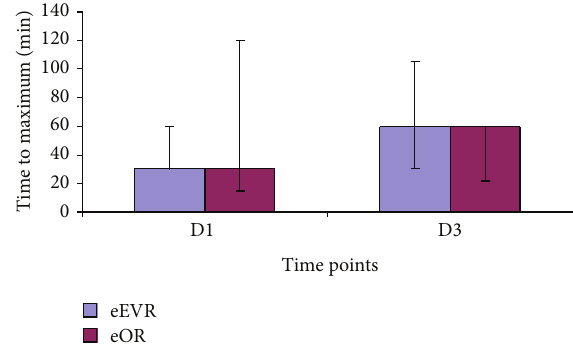
Figure 9: Time to reach maximum plasma paracetamol concentra- tion at D1 ( 𝑃 = 0.95 ) and D3 ( 𝑃 = 0.37 ) expressed as median and IQR (Mann-Whitney 𝑈 Test).